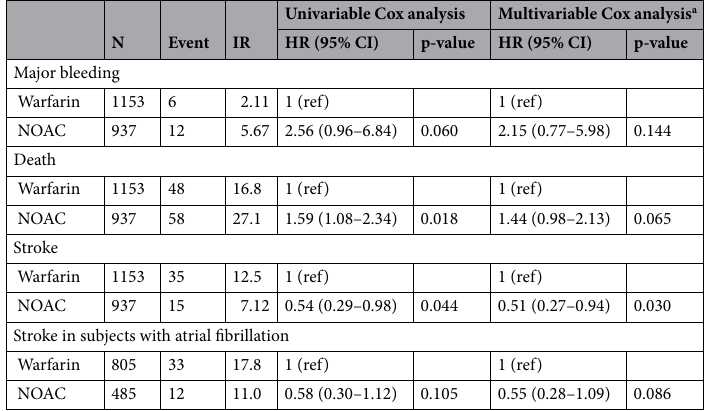
Table 2. Safety and effectiveness of anticoagulation in warfarin and NOAC users. NOAC non-vitamin K antagonist oral anticoagulant. a Adjusted for age, sex, CHA 2 DS 2 -VASc score, history of intracranial hemorrhage, history of gastrointestinal bleeding, chronic kidney disease, cancer, and concurrent antiplatelet